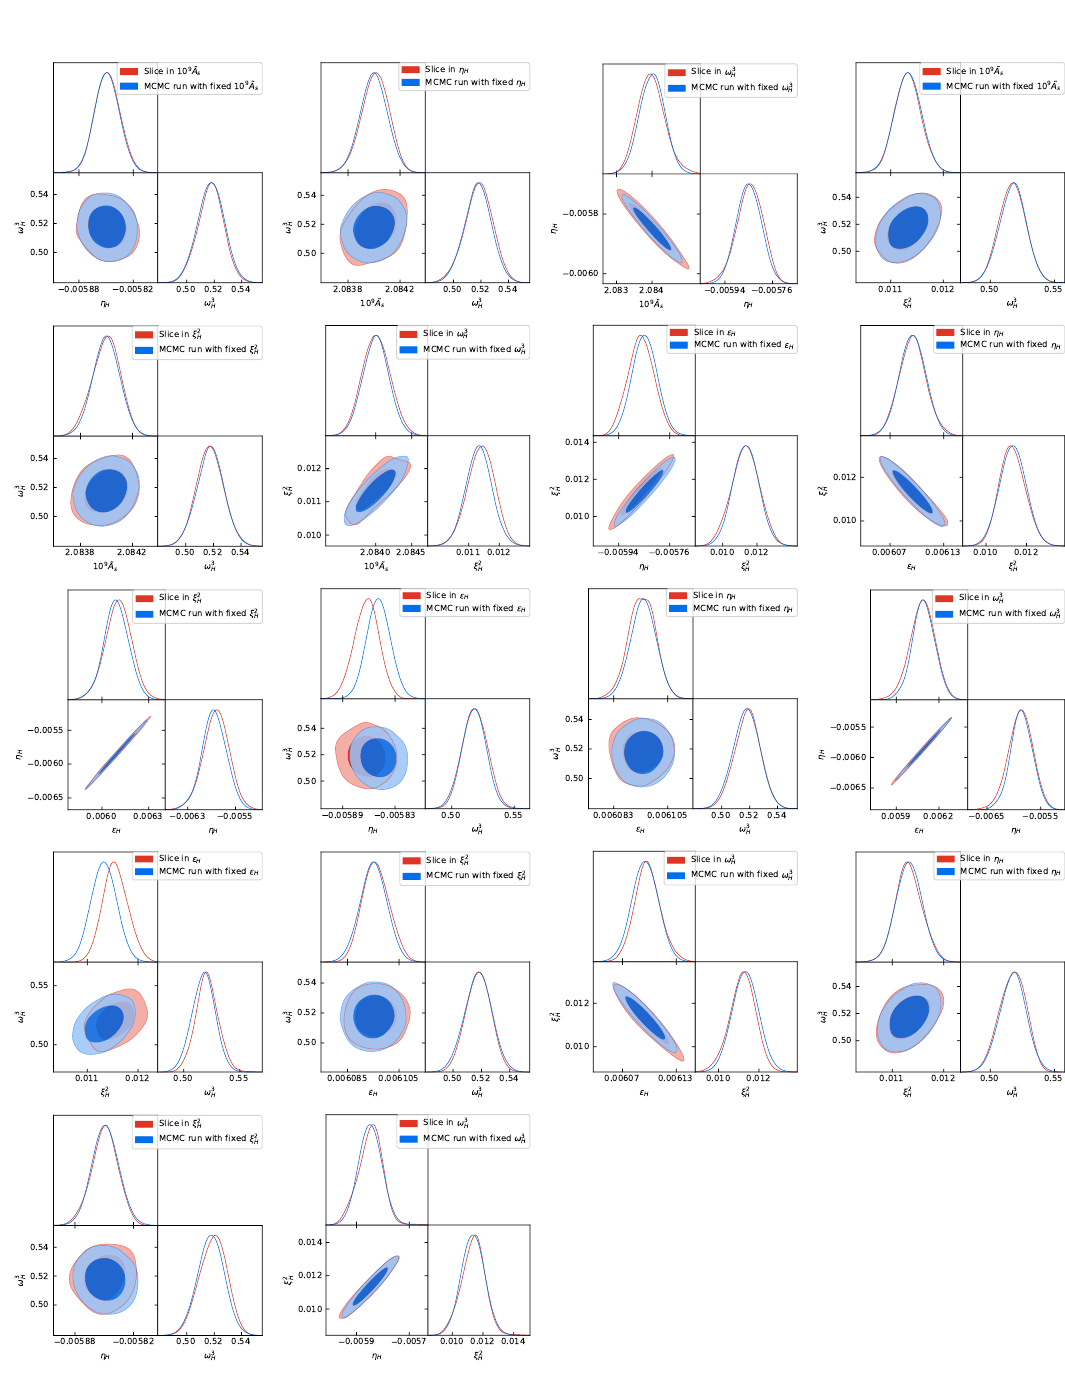
Figure 12: Comparison between slices and 2D contours using the SKA projections. Slices are taken from the 3D chains in Fig.